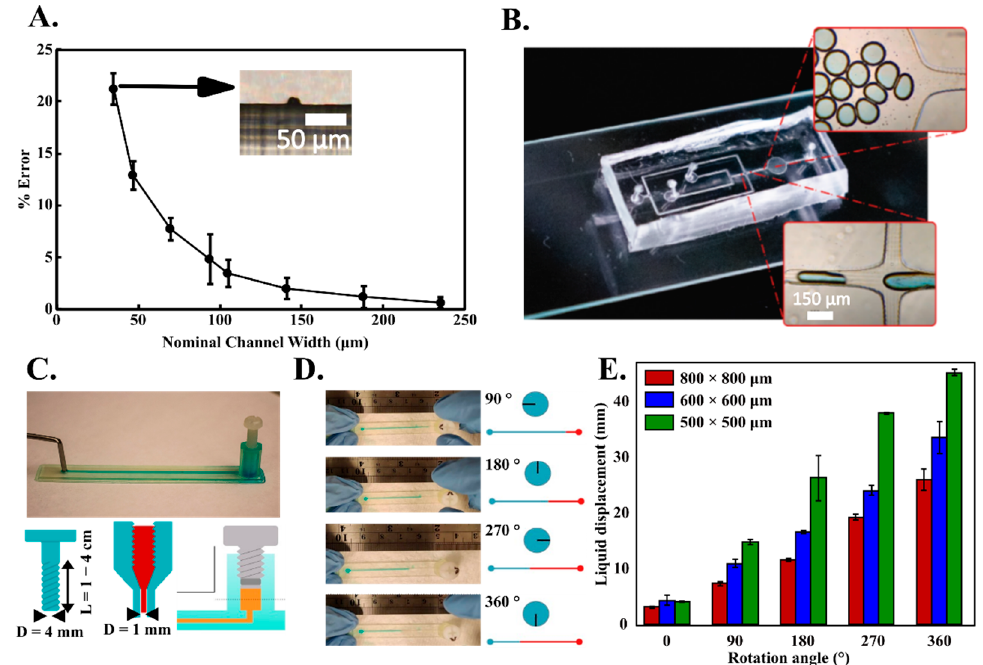
Figure 2. ( A ). Error between the nominal and printed channel dimensions using the SLA molds for PDMS casts to develop microfluidic devices. ( B ). A microfluidic droplet generator developed with an SLA printed mold yields channels with a width of 100 μ m capable to generating aqueous droplets ( C ). 3D printed finger twist screw with a corresponding fluid reservoir can be integrated with microfluidic channels to enable pump free fluid transport. ( D ). Finger-actuated fluid pumping enables precise liquid metering in a microfluidic chiap. ( E ). Tunable and precise liquid injection into microfluidic chips based on the screw rotation angle in different sized microfluidic channels.